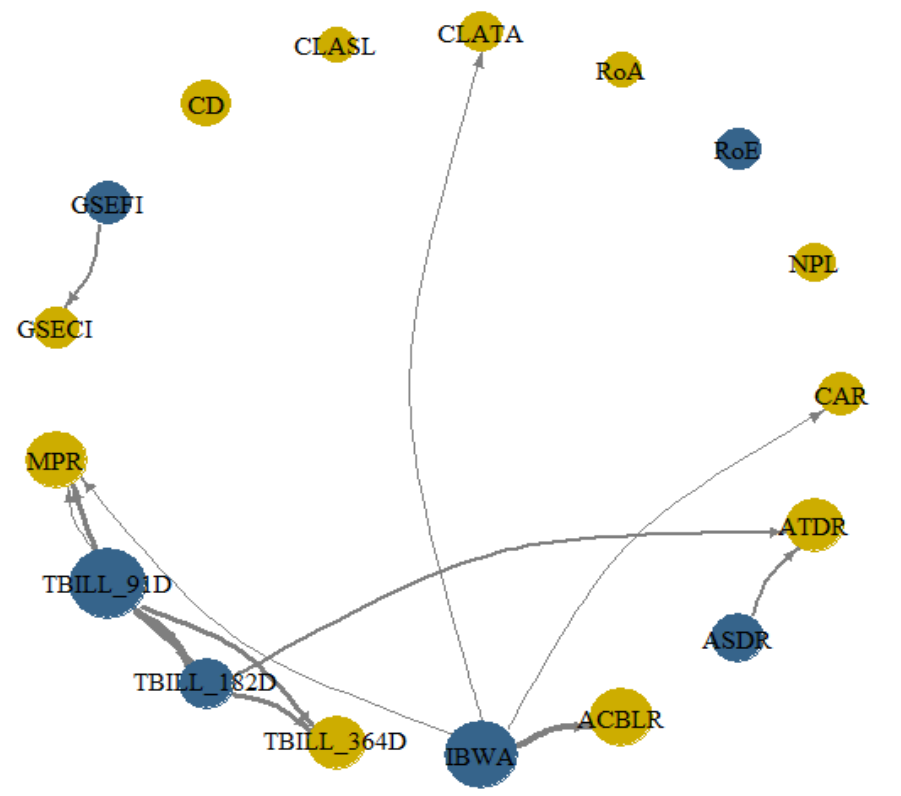
Figure 14. Net pairwise directional connectedness among indicators of GSE, financial soundness indicators and interest rates obtained through the DCC-GARCH connectedness approach. Notes: The arrows show net directional connectivity between two variables. The blue nodes illustrate net transmitters of shocks whereas brown nodes specify net receivers of shocks. The nodes’ size depicts weighted average net total directional connectedness.